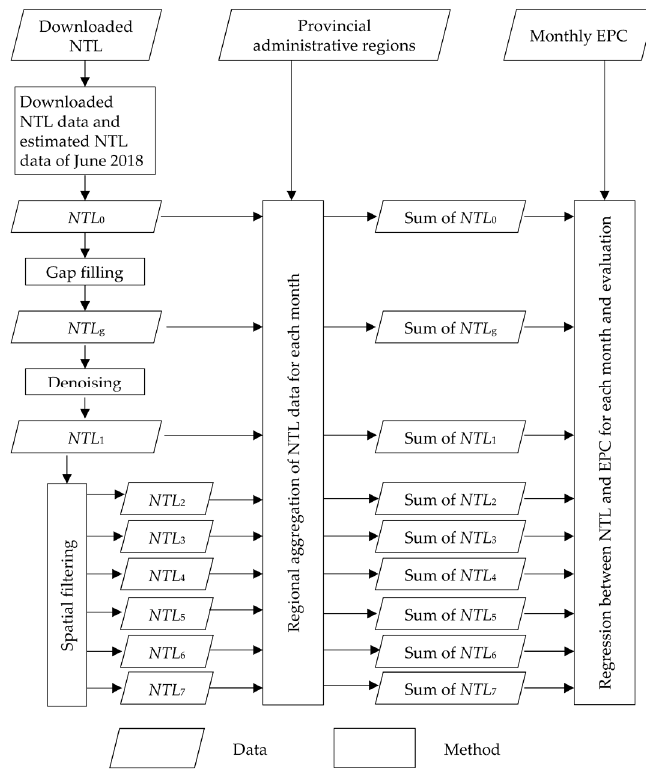
Figure 2. Flowchart of methodology.